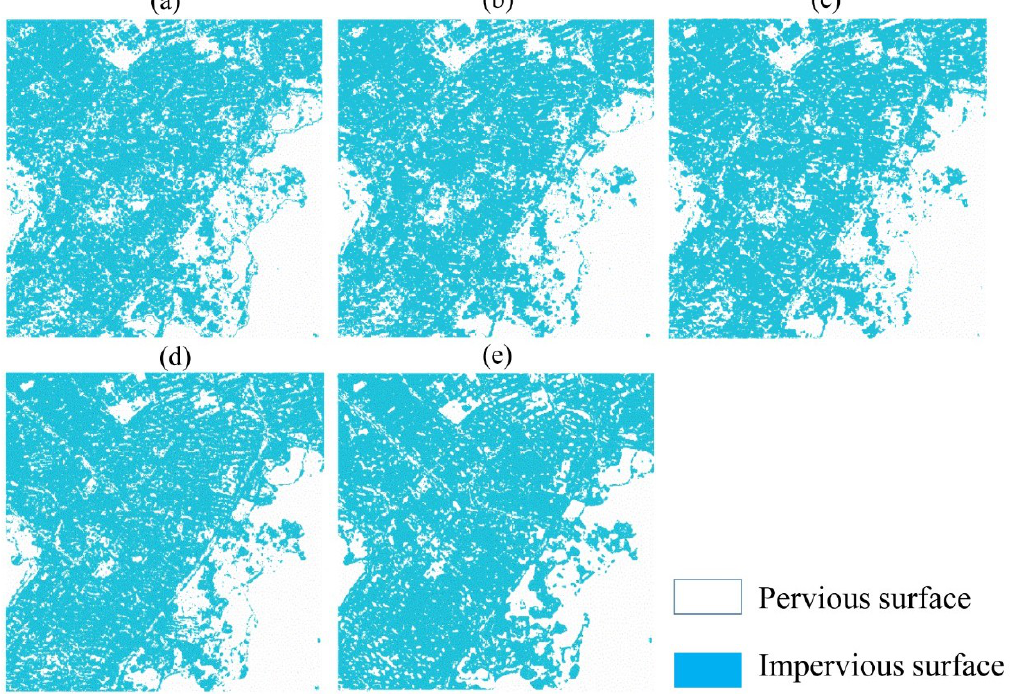
Figure 10. The IS extraction results using different images in Site 2: ( a – e ) IS results of IHS, GTF, DWT, IHS-GTF, and the Sentinel-2A image, respectively.